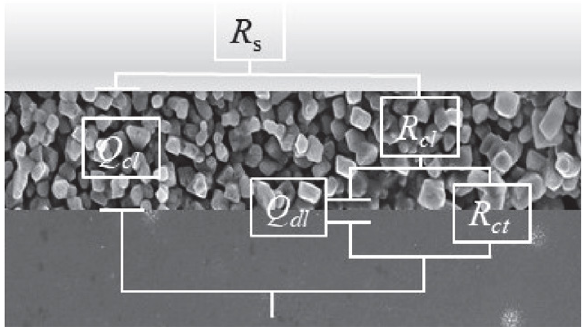
Figure 5. Equivalent circuit used for modelling the EIS